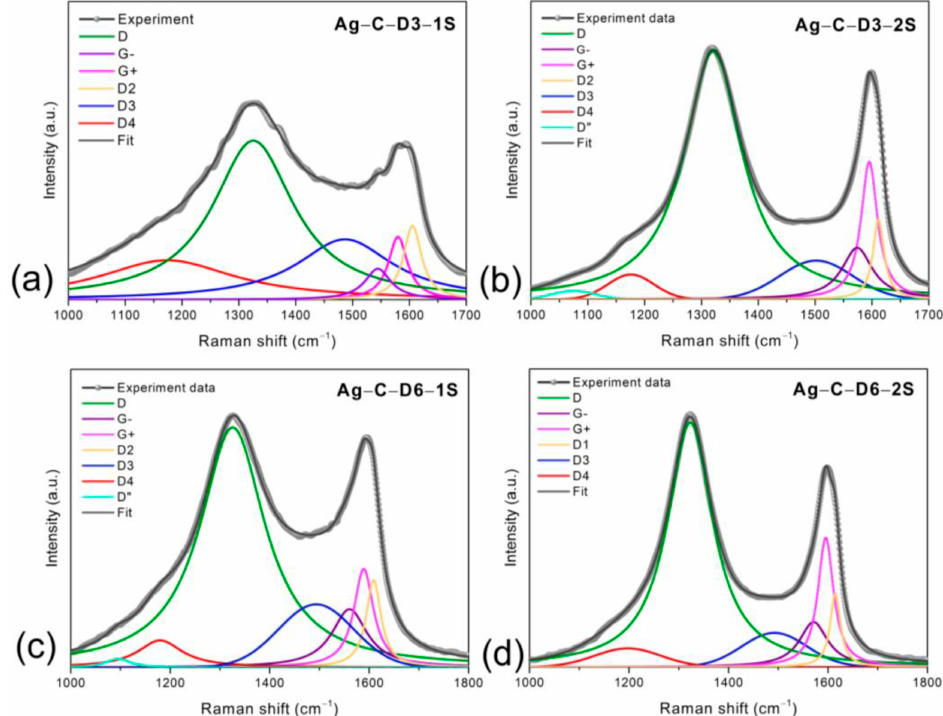
Figure 3. Fitted Raman spectra for carbon deposited on ZnO/Ag substrates at various nozzle-to- substrate distances and durations: ( a ) at 3 mm for 1 s, ( b ) at 3 mm for 2 s, ( c ) at 6 mm for 1 s, and ( d ) at 6 mm for 2 s.